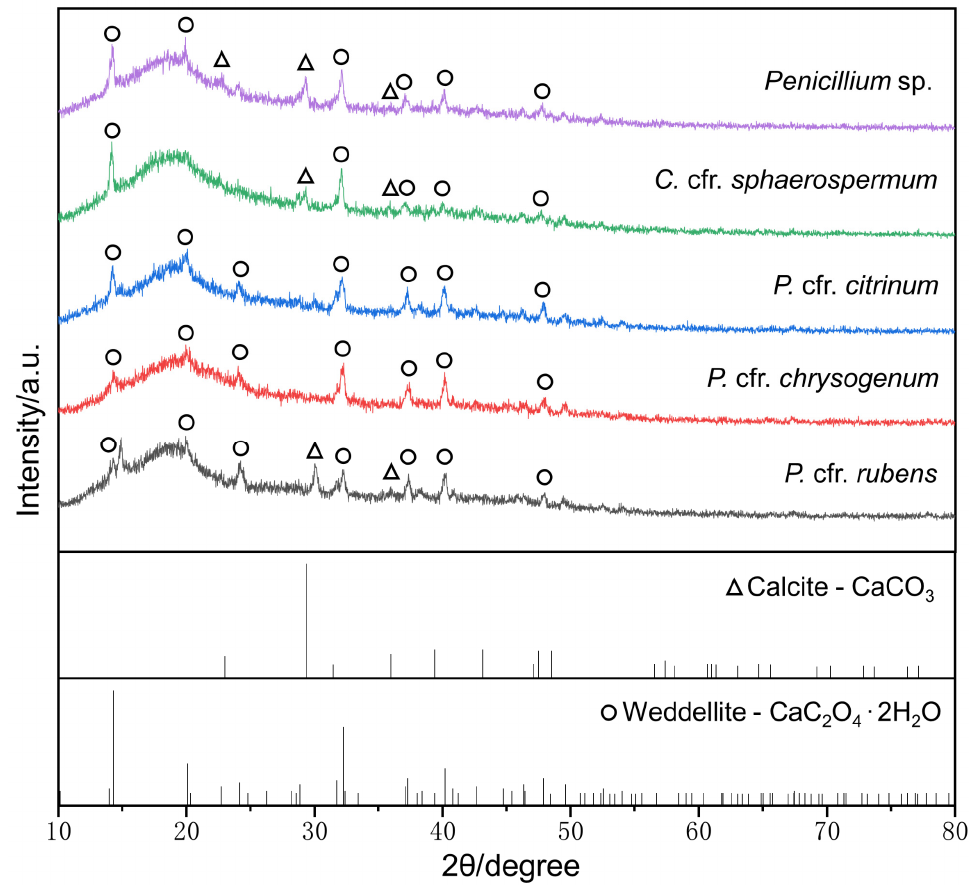
Figure 10. XRD analysis of MB4 medium inoculated with acid-producing strains. The XRD standard spectra were plotted from the PDF standard cards (calcite—PDF#05-0586, weddellite—PDF#17-0541).